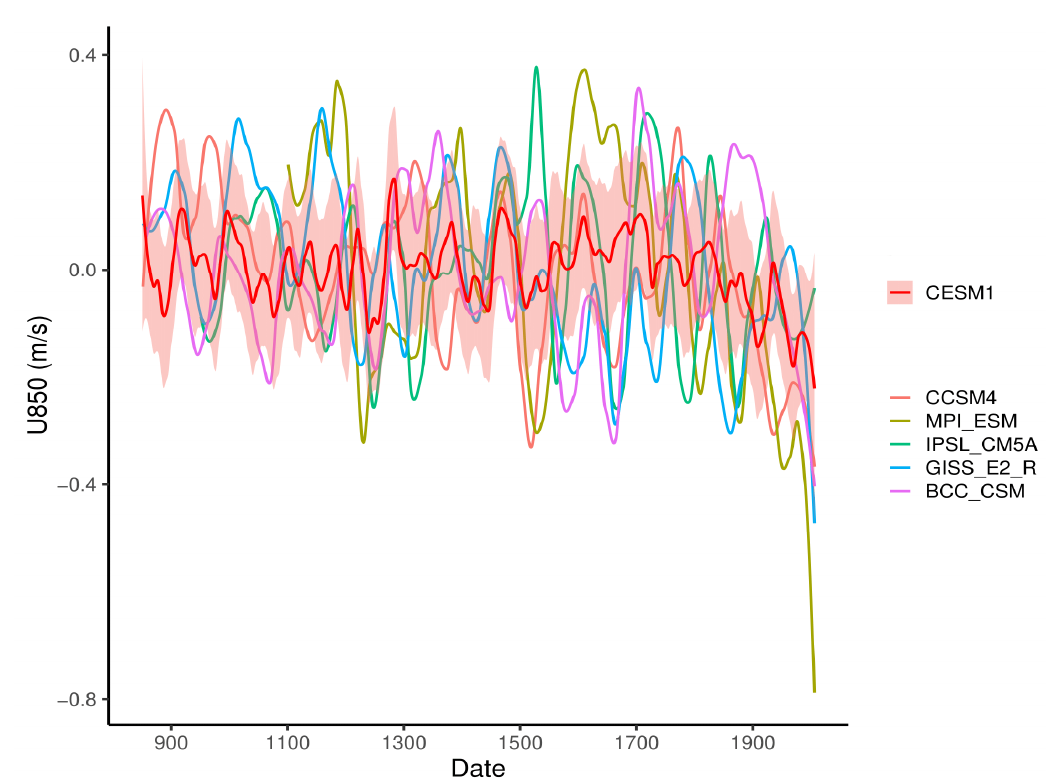
Figure 9. Loess-smoothed time series (30-year window) of simulated U850 (PMIP3 / CMIP5 models) over 850–2005. Red line represents ensemble mean for 10 CESM1 simulations and shaded red corresponds to standard deviation of the ensemble.